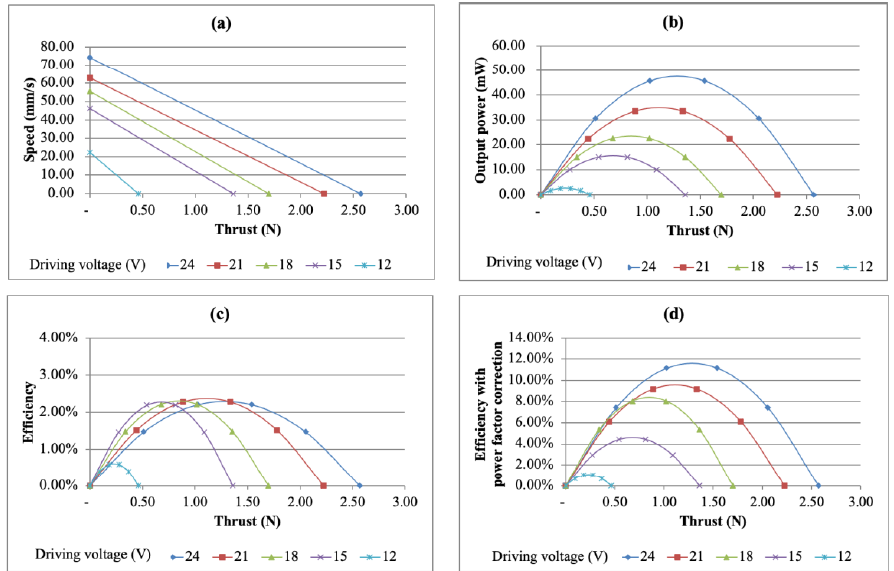
Figure 18. Performance of the multi-layer bimorph USM under different driving voltages. ( a ) Speed vs. thrust curve, ( b ) output power vs. thrust curve, ( c ) efficiency vs. thrust curve and ( d ) efficiency vs. thrust curve with a power factor correction.